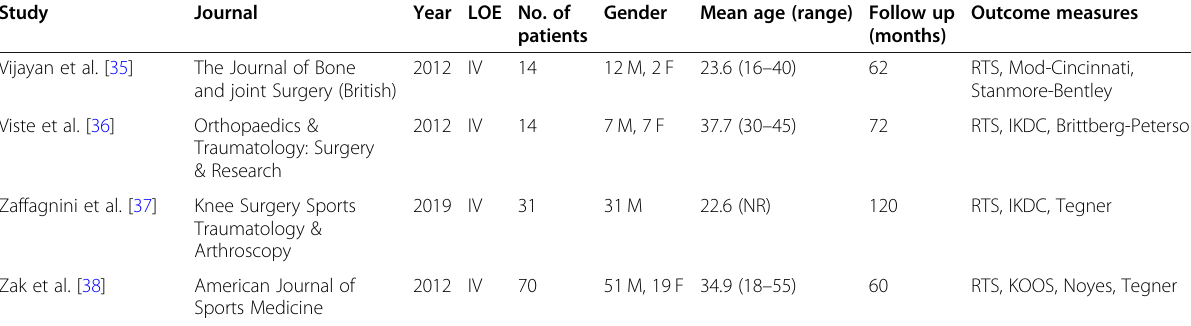
Table 1 Patient demographics and outcome measures of included studies (Continued) Study